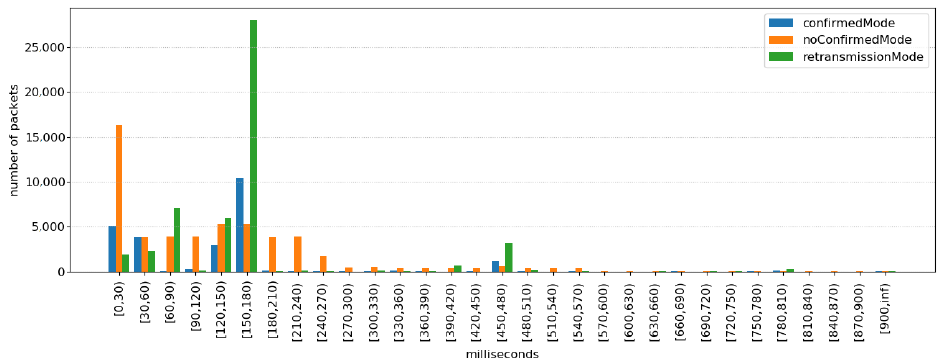
Figure 10. Distribution of packet’s latency in application